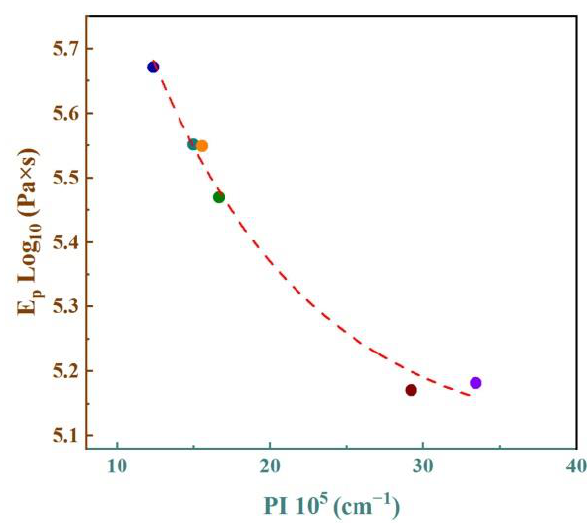
Figure 9. The fitting curve of PI and E p . The IC-30 sample had the smallest PI (12.37) and the largest E p (log 10 5.67),